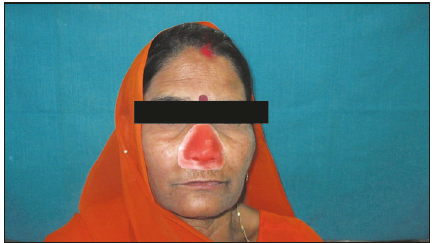
Figure 4: Evaluation of wax pattern on patient.